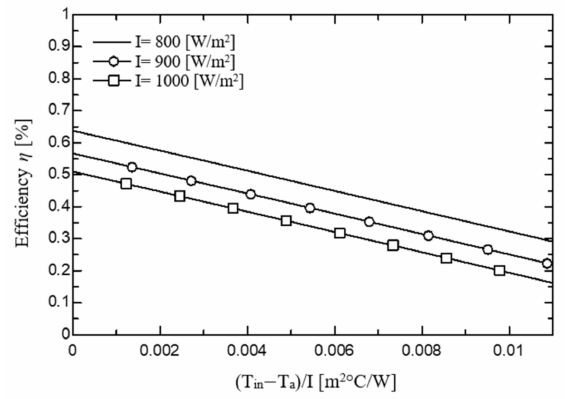
Figure 4. Instantaneous efficiency as a function of reduced temperature for different irradiation in a flat plate